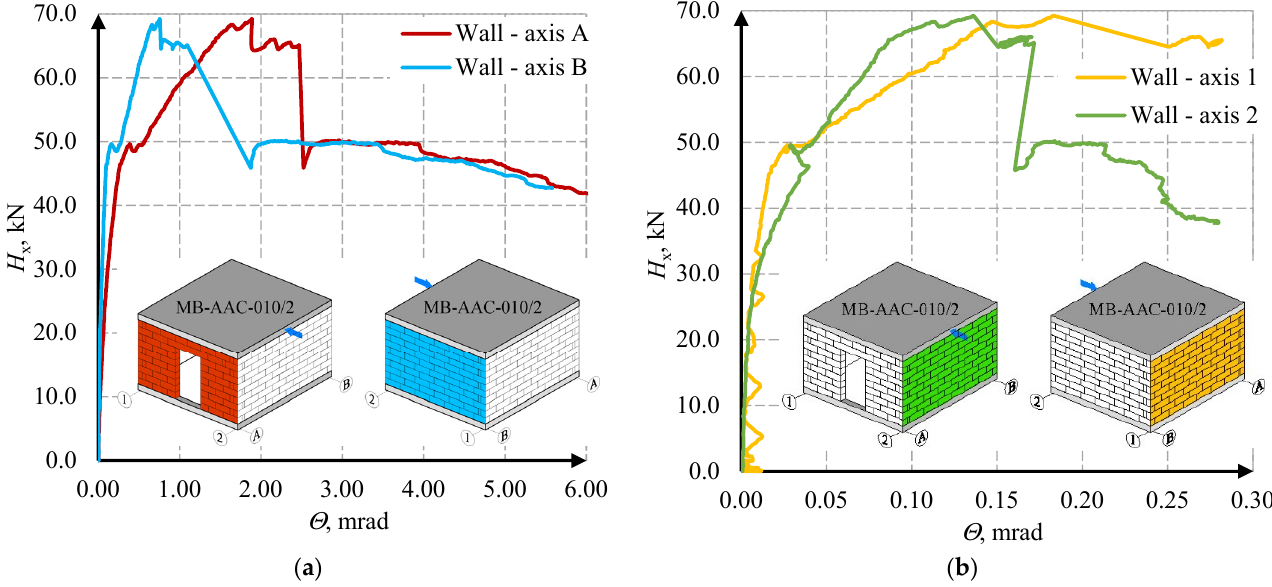
Figure 16. Relationship between horizontal force and strain deformation angle for MW-AAC-010/2 model; ( a ) results for A and B wall ( b ) results for 1 and 2 wall.